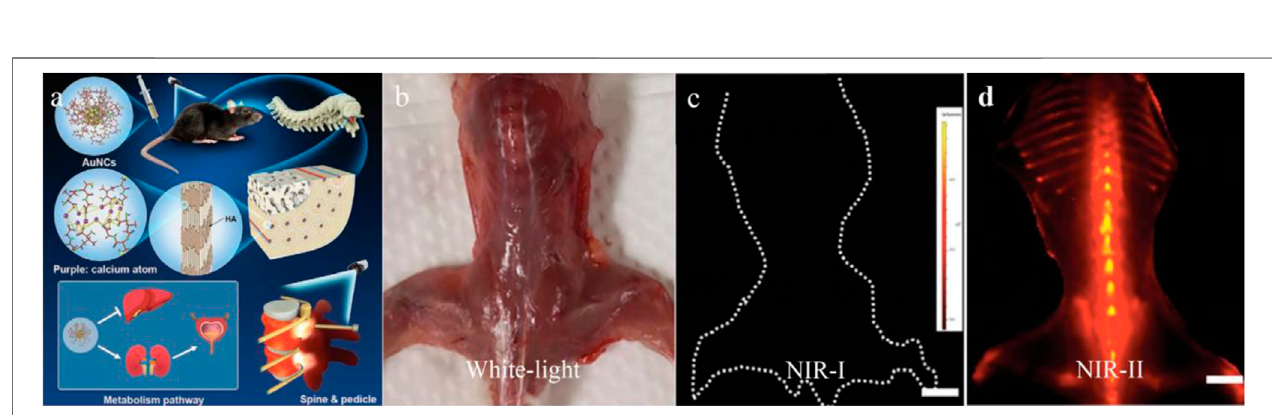
FIGURE 3 | NIR-II imaging of osteosarcoma lung metastasis imaging with high imaging contrast and resolution by CH1055-PEG-Af fi body. (A) NIR-II fl uorescent signals of the lung for lung metastasis evaluation. (B) H&E staining results of parts 1, 2, 3, and 4 in the NIR-II lung imaging supported that probe could diagnose small lesions ( < 1 mm in diameter) that could not be detected by the CT technique. Reproduced with permission from Zhou et al. (2019).